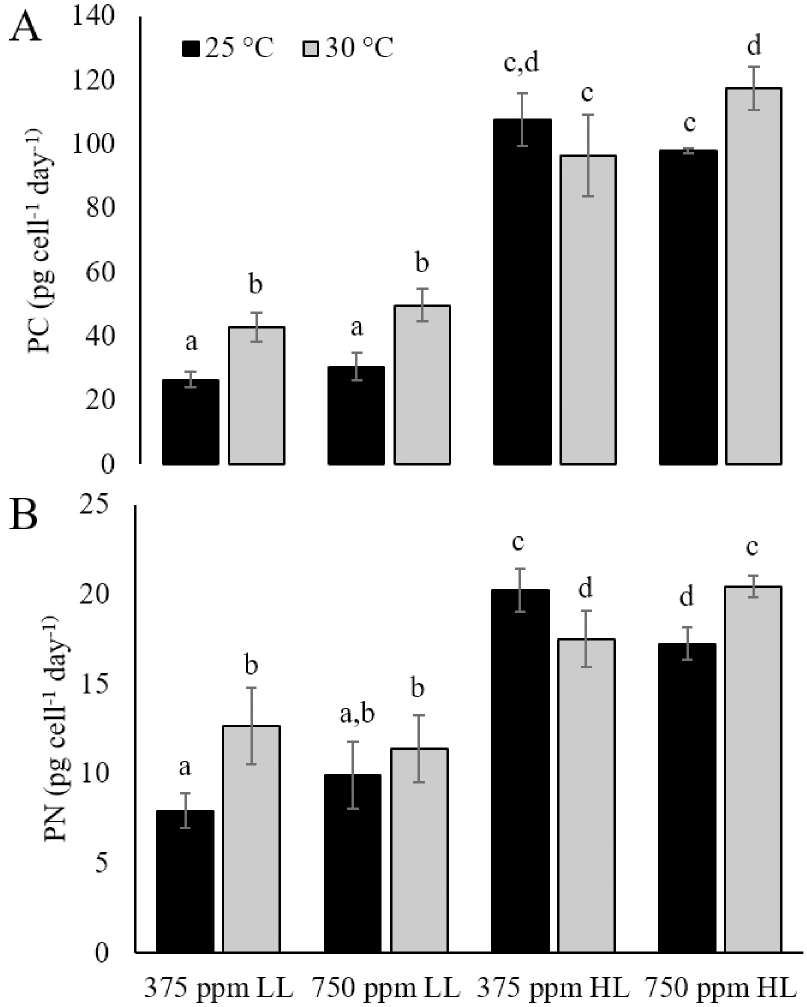
Fig 4. Rates of carbon and nitrogen production. Production rate of A) particulate carbon (PC) and B) particulate nitrogen (PN) in Karlodinium veneficum in ambient (25˚C) and elevated (30˚C) temperature in combination with ambient (375 ppm) and elevated (750 ppm) CO 2 under Low Light (LL; 70 ± 2 μ mol quanta m -2 s -1 ) and High Light (HL; 140 ± 3 μ mol quanta m -2 s -1 ) conditions. Errors denote the standard deviations of quadruplicate samples. Letters indicate significant differences (p <